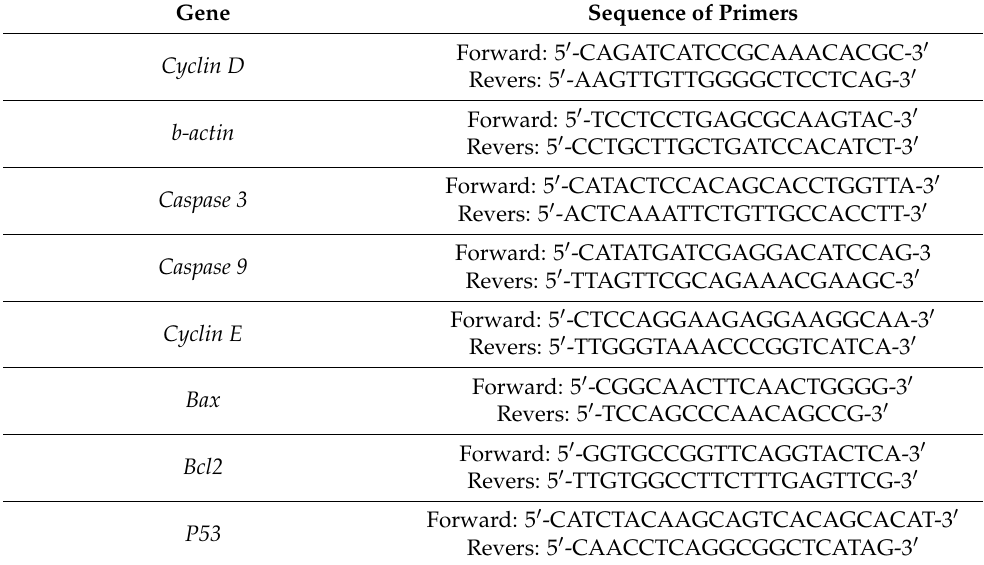
Table 3. The sequence of primers used in